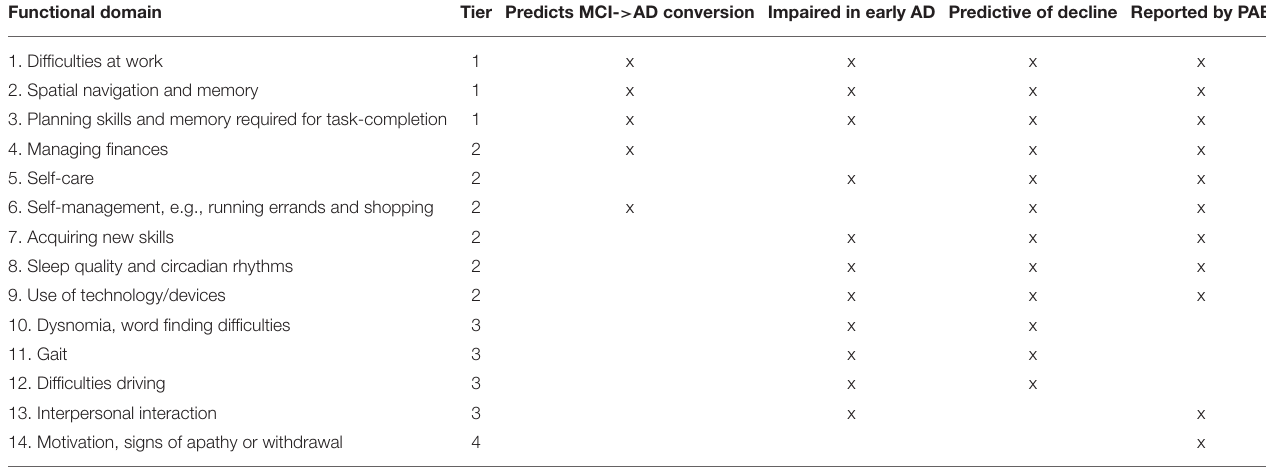
TABLE 1 | The functional domain selection process resulted in the identification of the following functional domains, sorted by relevance. Functional